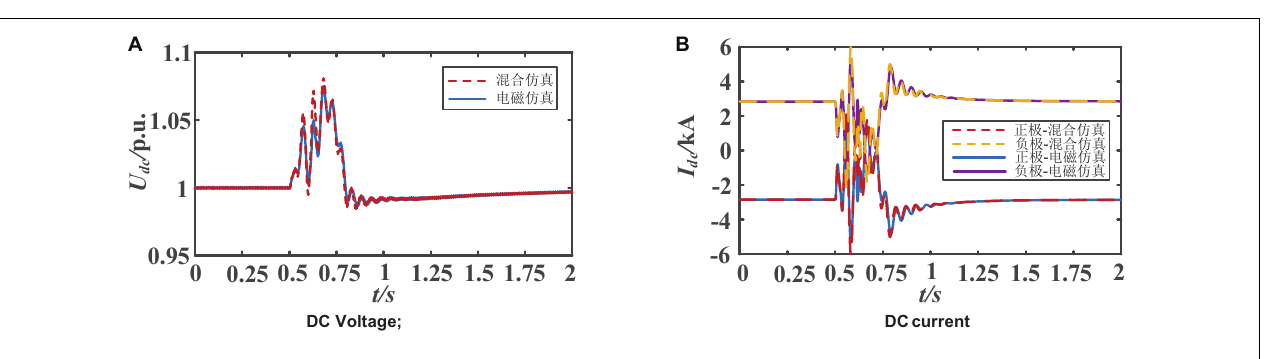
FIGURE 13 | Dynamic characteristics of Beijing station; (A) DC Voltage; (B) DC